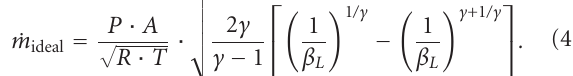
Figure 4: Pressure distribution for Geom